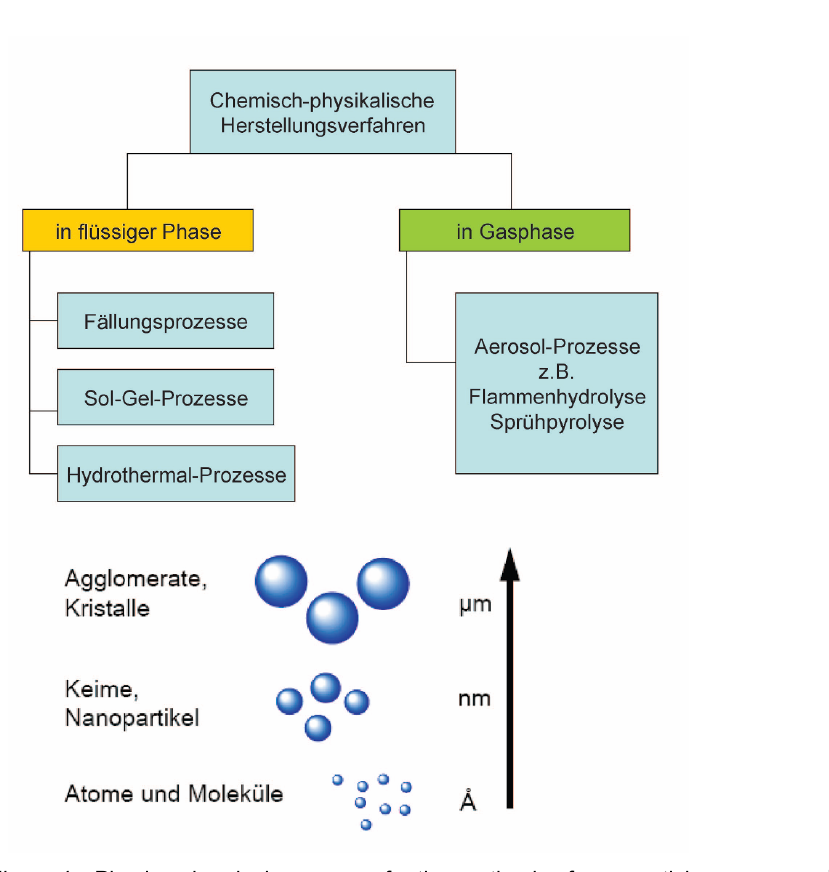
Figure 4 – Physico-chemical processes for the synthesis of nanoparticles (Raab et al, 2008, pp.